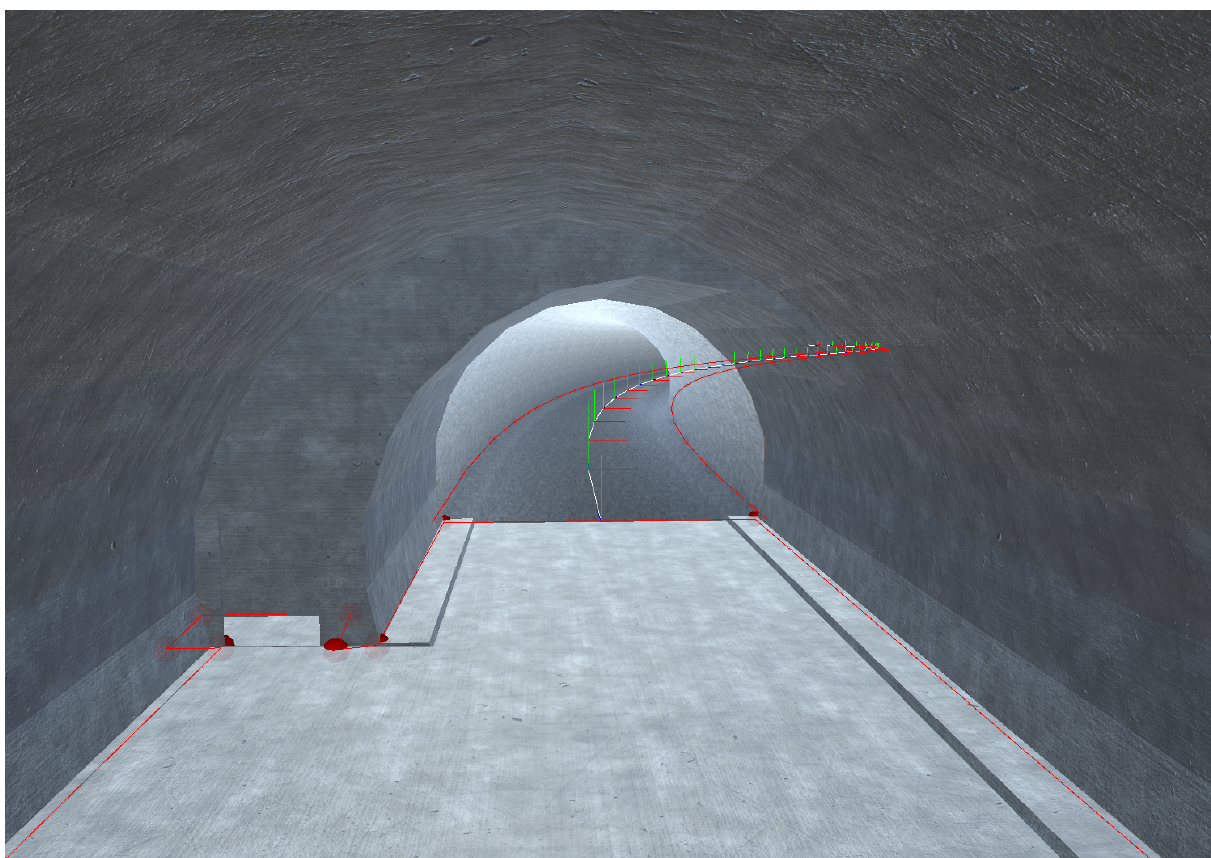
Figure 4. View in Fast Tunnel Modelling Tool (FTMT) from breakdown bay into a tunnel (map polygon (MP) in red, tunnel axis in